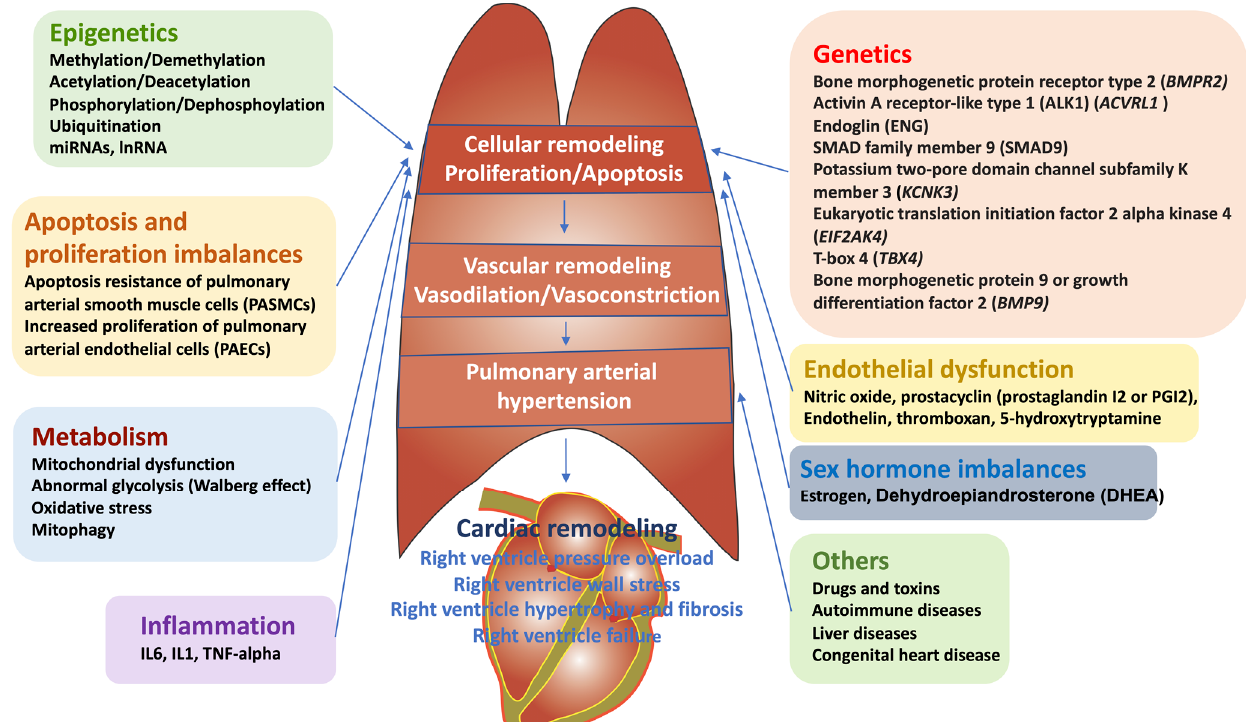
Figure 1. Major pathophysiological mechanisms that lead to vascular remodeling increased pulmo- nary artery and, thus, right-ventricle remodeling. The sequential pathological events of vascular remodeling in PAH include increased proliferation of smooth muscle cells, subsequent musculari- zation of peripheral pulmonary arteries, and medial hypertrophy in pulmonary muscular arteries. Further intimal fibrosis occurs by infiltration of inflammatory cells and progressive migration of smooth muscle cells. As a consequence, plexiform lesions and vessel occlusion cause reduced blood flow, resulting in PAH as progression of PAH.